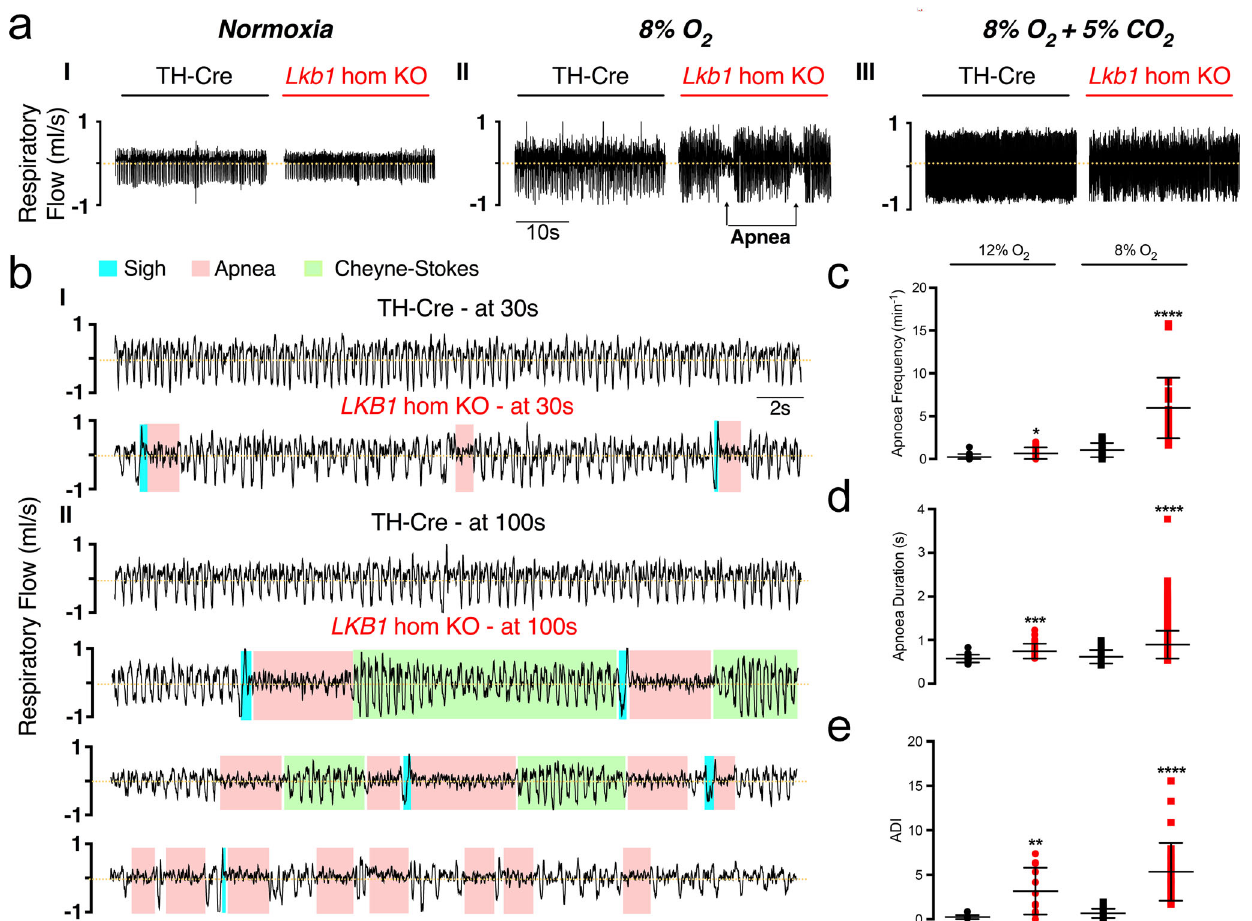
Fig. 7 Conditional deletion of Lkb1 in tyrosine hydroxylase expressing cells precipitates hypoventilation, apnoea and Cheyne-Stokes-like breathing during severe hypoxia. a Example records of ventilatory activity from TH-Cre and conditional Lkb1 homozygous knockout mice ( Lkb1 hom KO) during (I) normoxia (21% O 2 ), (II) hypoxia (8% O 2 ) and (III) hypoxia with hypercapnia (8% O 2 + 5% CO 2 ), that were obtained using whole body plethysmography. b (I – II), Typical ventilatory records for TH-Cre and conditional Lkb1 hom KO mice on an expanded time scale at the indicated time points during exposures to severe hypoxia (8% O 2 ). Dot plots show mean ± SEM for c apnoeic frequency, d apnoea duration and e apnoea-duration index (frequency × duration) for TH-Cre (black; 12% O 2 , n = 19 independent experiments; 8% O 2 , n = 24 independent experiments) and conditional Lkb1 hom KO mice (red; 12% O 2 , n = 17 independent experiments; 8% O n = 29 independent experiments) during exposures to 12% O + 5% CO = p < 0.05, 2 , 2 , 8% O 2 and 8% O 2 2 . * ** = p < 0.01, **** = p <